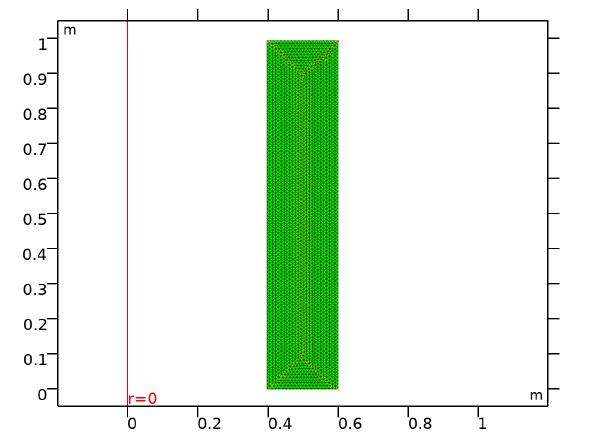
Figure 3. Finite element meshing of cross-section for an axisymmetric functionally graded